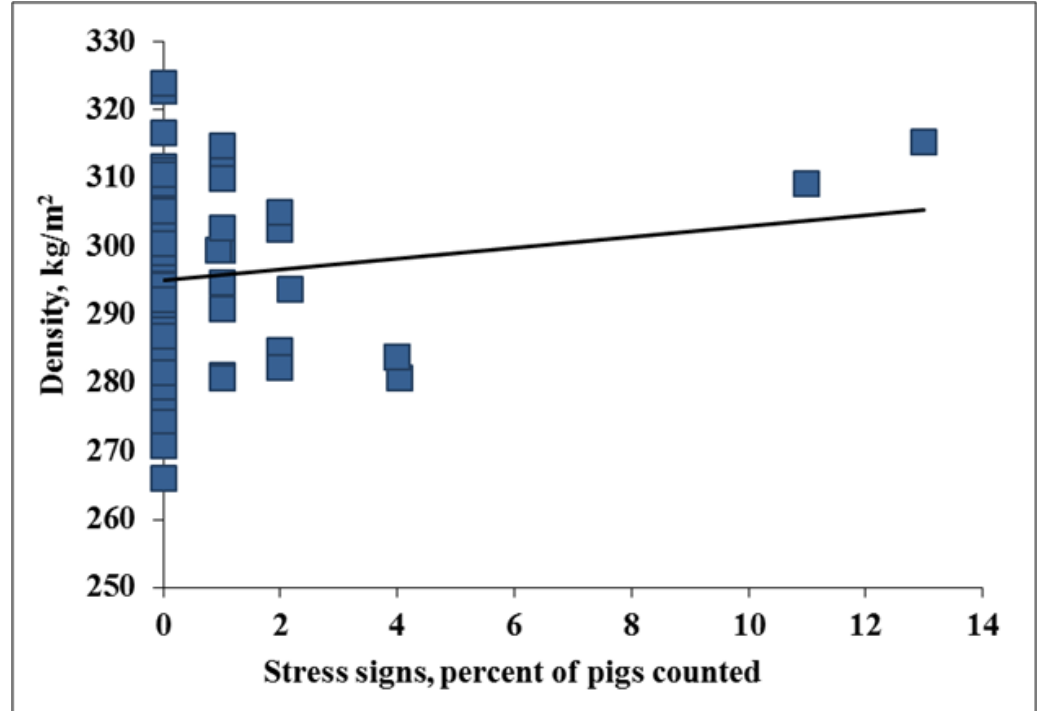
Figure 3. Experiment 1. Effects of trailer stocking density on stress signs ( p = 0.03; R 2 =